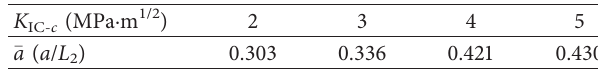
Figure 21: Thermal crack numbers with a different ceramic fracture toughness ( t � 1.0s). Table 6: Average crack lengths with a different ceramic fracture toughness ( t �